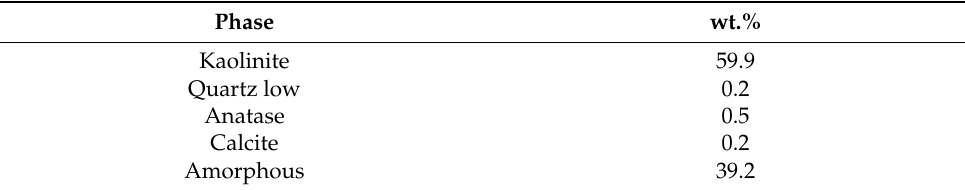
Table 3. Phase composition of waste diatomite.